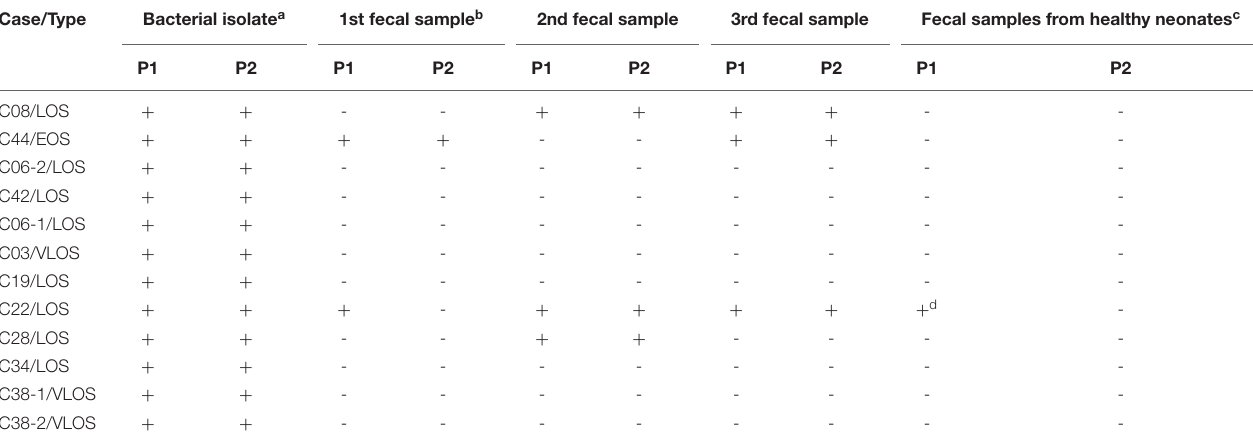
TABLE 3 | PCR to identify bacterial pathogens in fecal samples collected from the preterm infants with